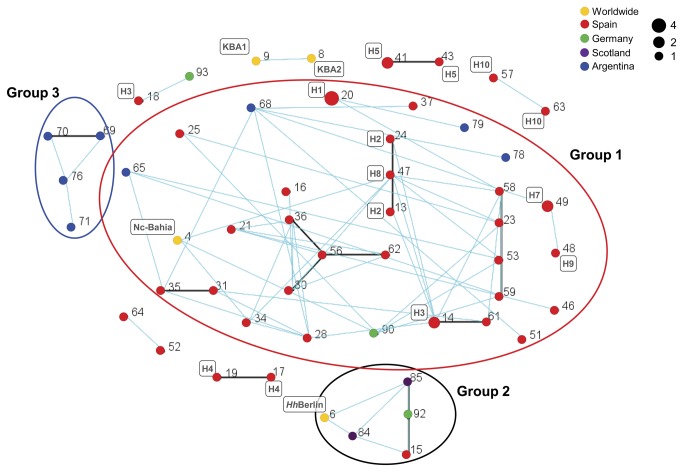
Relationships among the

N

. caninum
 MLGs (n = 82) estimated by eBURST analysis.Each complete MLG is represented by a dot and the genotype number assigned in Table S1 (Numbers 1-11 represent worldwide MLGs; 12-64 Spanish MLGs; 65-80 Argentinean MLGs; 81-88 Scottish MLGs; and 89-95 German MLGs). MLG dots were also coloured according to their geographical origin (see legend). The dot diameter is proportional to the number of samples with identical MLG (see legend). Single locus variants (SLV) are connected by black lines and double loci variants (DLV) by blue lines. MLGs clusters (n=9) are represented. Main MLGs clusters (n=3) are showed by clear circles. Number and name in the squares identifies the herd origin and worldwide isolates, respectively (see Table S1). Note that singletons were excluded from the snapshot representation (worldwide n=7; Spanish n=7; Argentinean n=2; Scottish n=3; and German n=2).